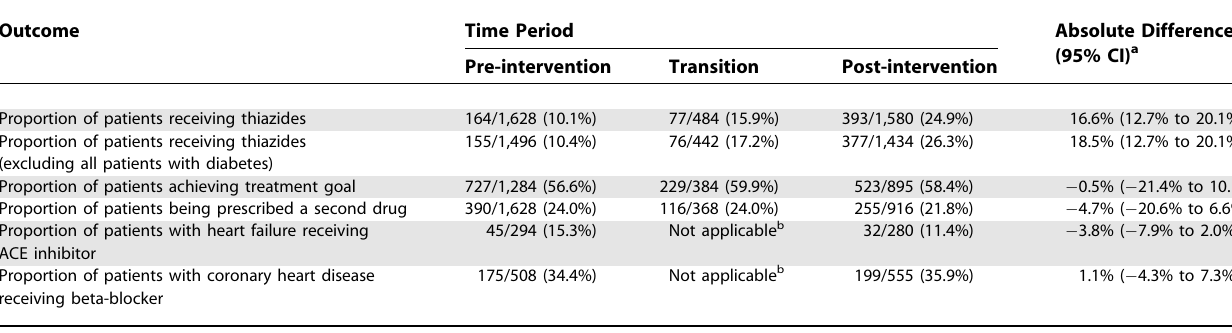
Table 2. Main Findings, Aggregated per Time Period Outcome